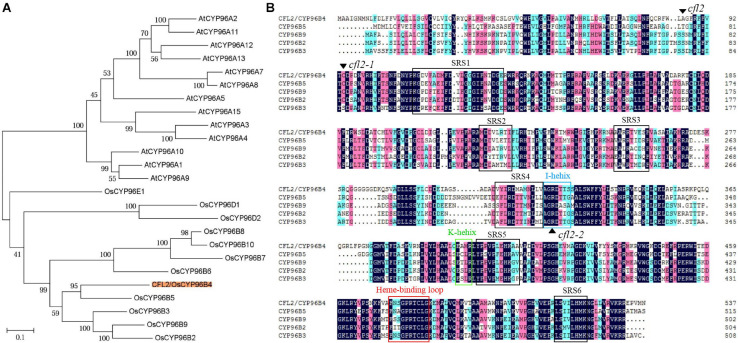
Protein bioinformatics analysis of CFL2. (A) Phylogenetic tree of CYP96 subfamily in rice and Arabidopsis. (B) Multiple sequence alignment of the CYP96 subfamily gene cluster on chromosome 3. The black arrowhead indicates the amino acid residue mutated in mutants. The open box with different color represent the conserved structures domains of CYP proteins, including SRS (substrate-recognition sites), I-helix (I-helix groove), K-helix (Glu-x-x-Arg domain), and a heme binding loop.